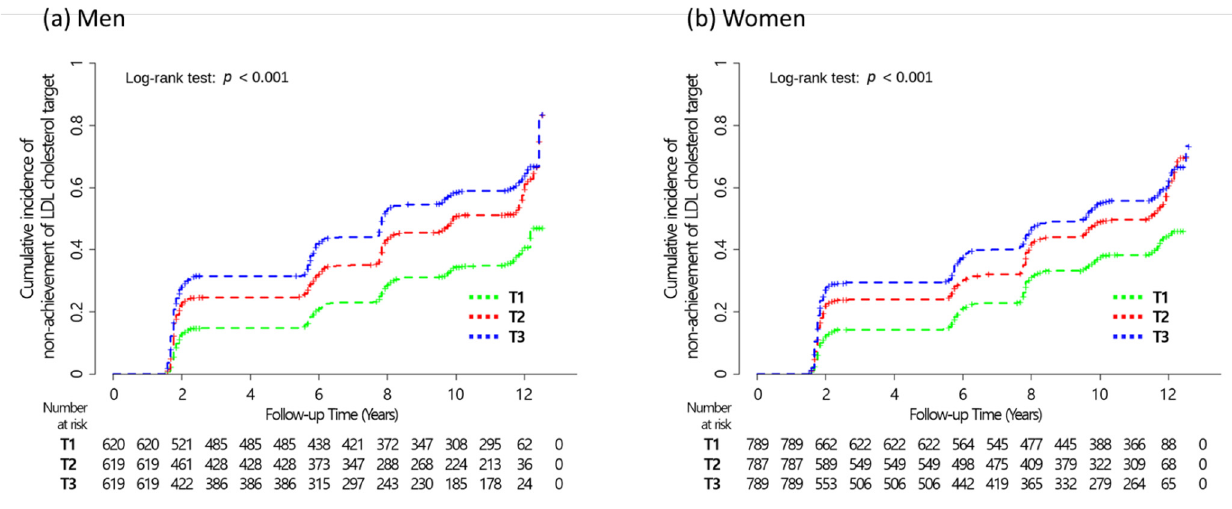
Figure 3. Kaplan–Meier curves for the cumulative incidence of non-achievement of LDL cholesterol targets according to sex-specific FMR tertile groups in ( a ) men and ( b ) women. Abbreviations: LDL, low-density lipoprotein; FMR, fat-to-muscle ratio; T, tertile.